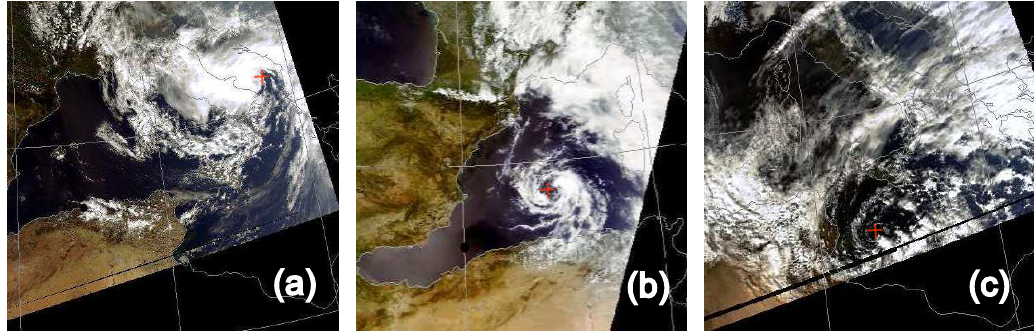
(c)(b)(a) Fig. 1. MODIS satellite composite images (http://www.sat.dundee.ac.uk) of the three medicanes considered in this study: (a) 26 September 2006, 12:45UTC, (b) 27 May 2003, 11:09UTC, (c) 14 December 2005, 12:29UTC. Red crosses indicate the position of the